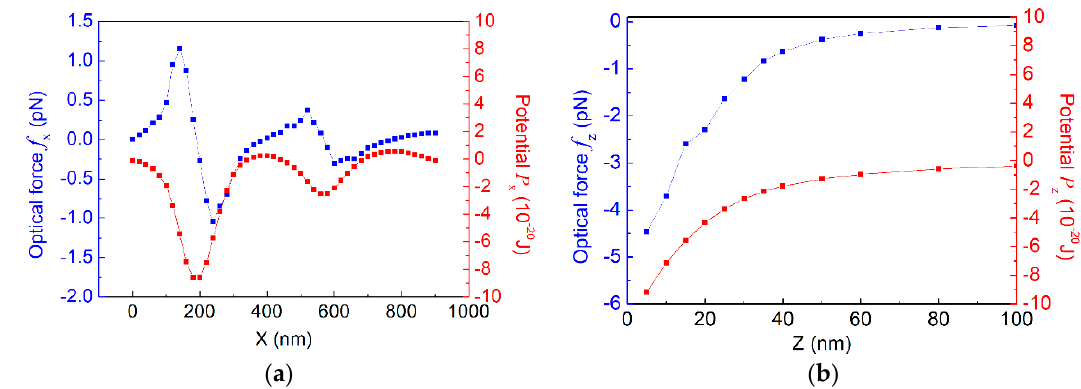
Figure 4. The optical force and potential on the particle ( a ) in the x direction and ( b ) in the z direction with the input light power of 100 μ W.